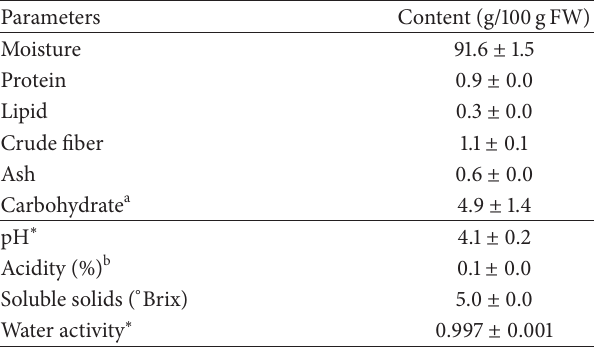
Table1:Proximalcomposition,pH,acidity,solublesolids,andwater capacity of fresh Chilean